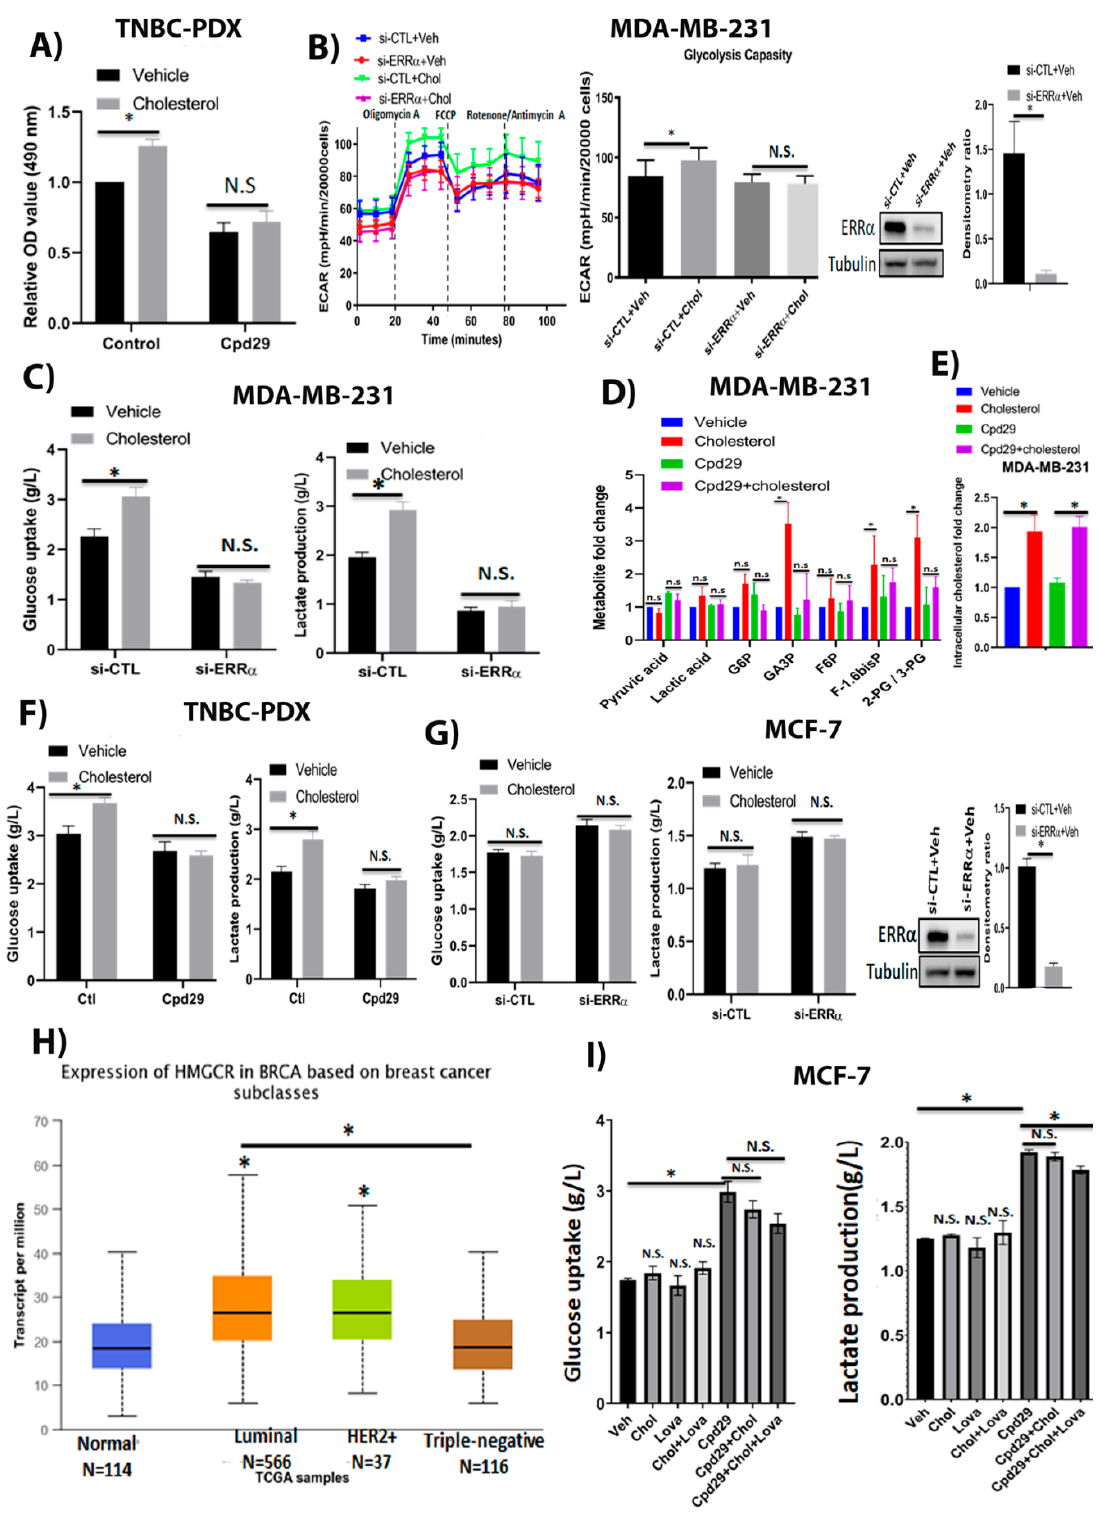
Figure 1. Cholesterol promotes cellular growth in TNBC-PDX cells, and enhances the abundances of glycolytic metabolites in TNBC cells, but not in ER+ breast cancer cells, in an ERR α -dependent manner. ( A ) TNBC-PDX cell proliferation was measured using an MTS kit in the presence of vehicle (Veh), cholesterol (Chol, 10 μ M), and/or cpd29 (10 μ M) on day 6. Ctl (control) represents the breast cancer cells treated with cholesterol or vehicle. ( B ) MDA-MB-231 cells were transfected with siRNA-control (si-CTL) or siRNA-ERR α (si-ERR α ) and then treated with vehicle (Veh) or cholesterol (Chol, 5 μ M) for 24 h. The extracellular acidification rate (ECAR) was obtained using the Seahorse XF96. Glycolysis capacity was measured after oligomycin drug injection. MDA-MB-231 cells were transfected with either siRNA-control (si-CTL) or siRNA-ERR α